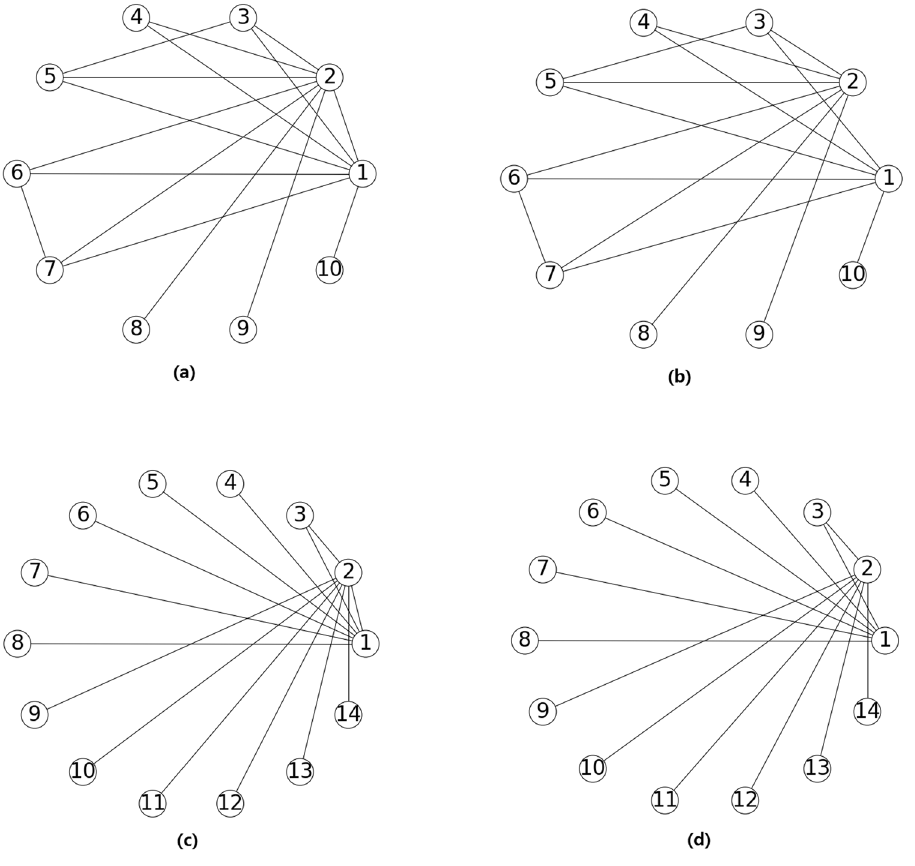
Figure 5. Four toy